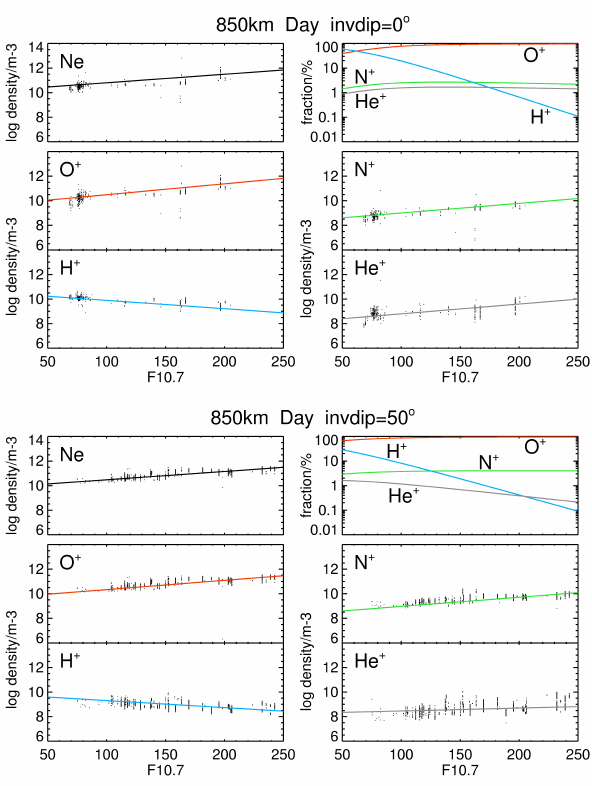
Fig. 6. Dependence of the logarithm of the individual ion densities, of the electron (=total ion) density, and of the relative ion densi- ties on the solar activity level characterized by the actual day val- ues of the F10.7 index. Example for equinox, equator ± 15 ◦ , mid- latitudes 50 ◦ ± 15 ◦ , altitude of 850 ± 90km, and nighttime 0 ± 3h MLT. Points-measured values, lines-values calculated from the models (TTS relative ion density and electron density